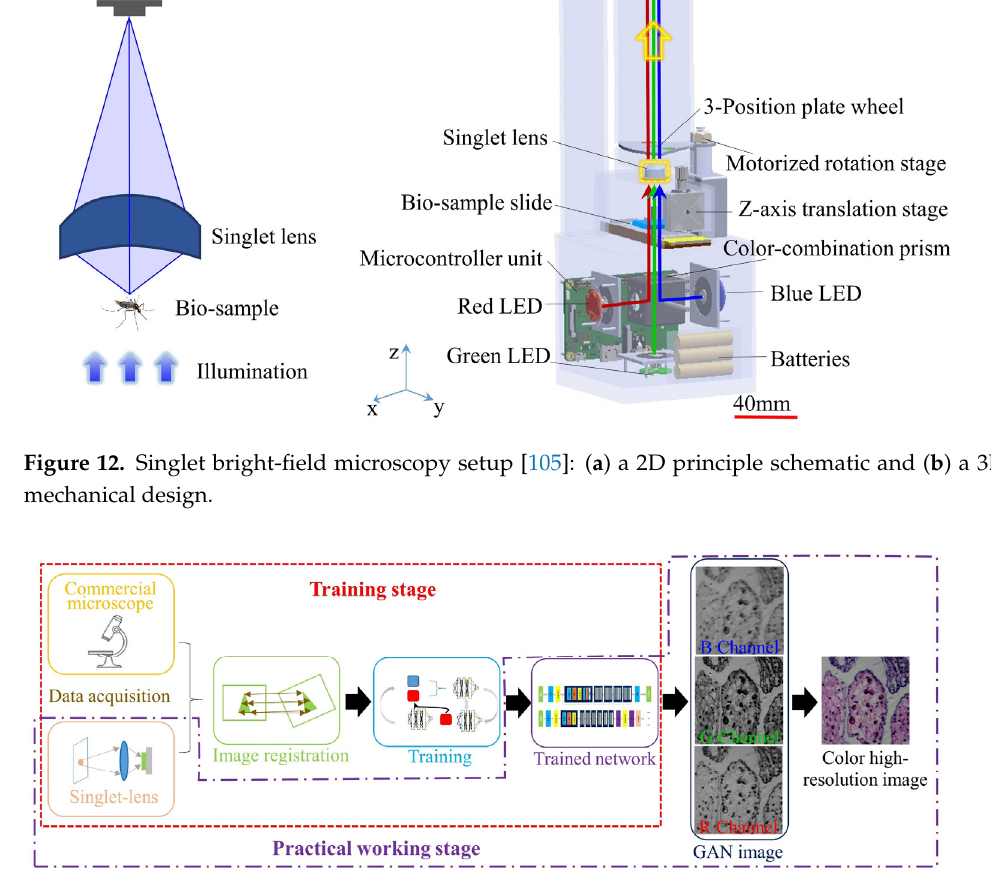
Figure 13. Deep learning architecture to enhance high-resolution and image contrast for the singlet bright-field microscopy in Figure 12 [105].